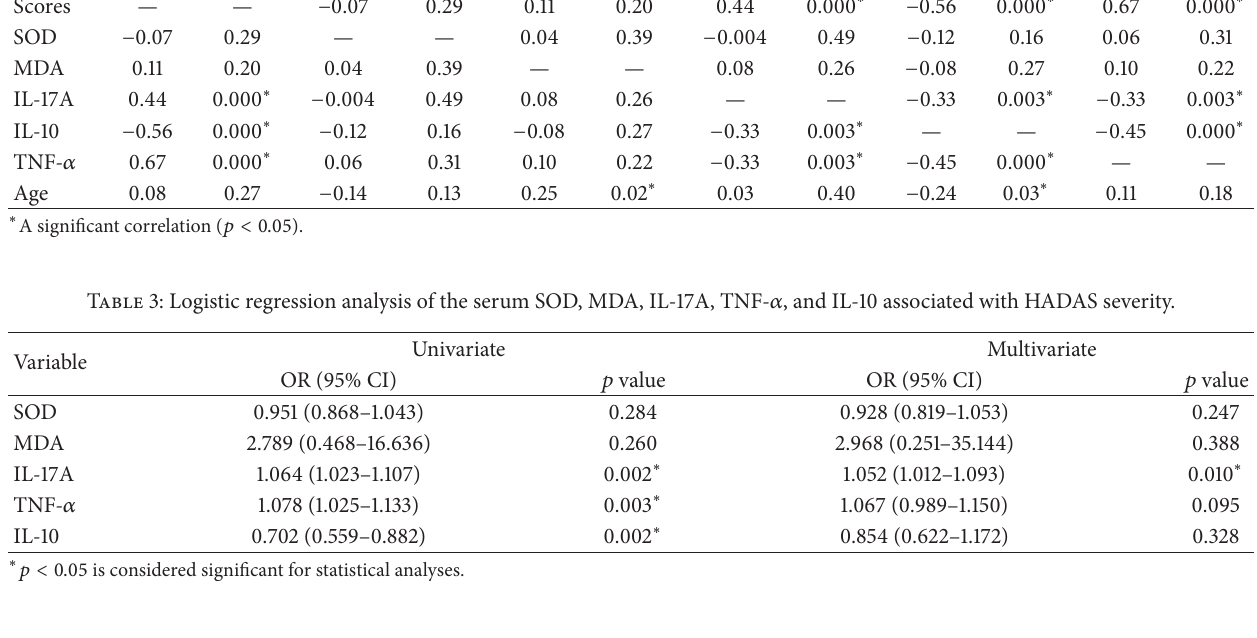
Table 4: Logistic regression analysis of the serum IL-17A, TNF- 𝛼 , and IL-10 associated with HADAS